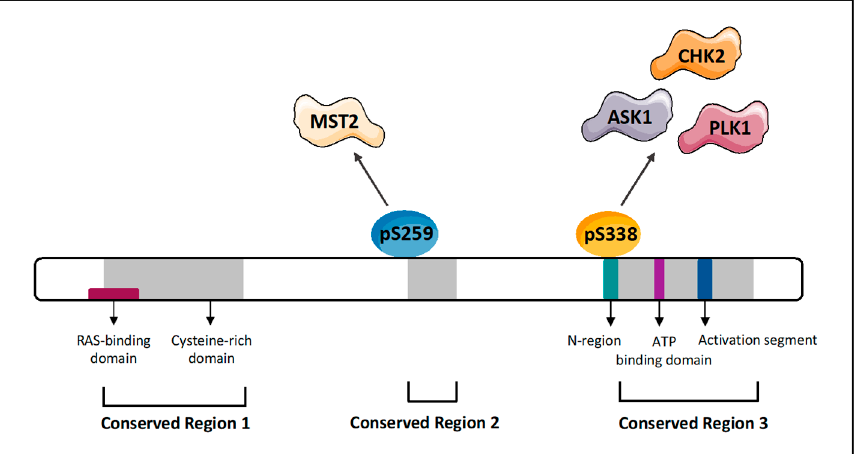
Figure 3. RAF1 protein structure. The phosphorylation sites indicate the residues that are known to be phosphorylated when RAF1 binds to its kinase-independent effectors.